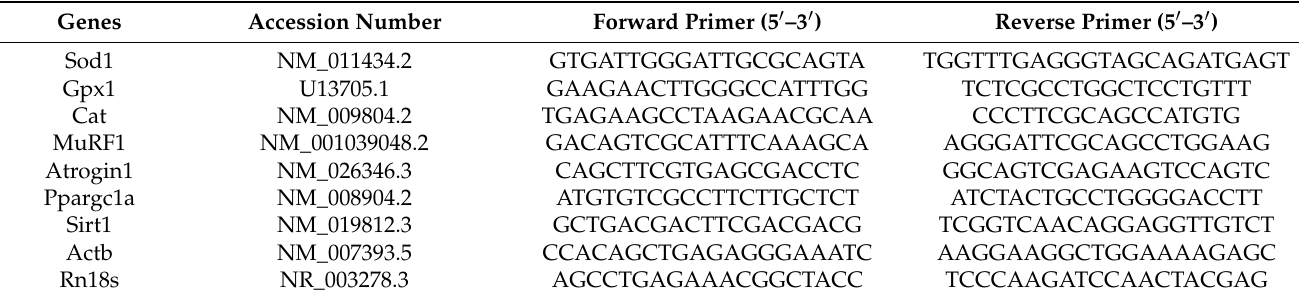
Table 1. Primer sequences used for quantitative real-time